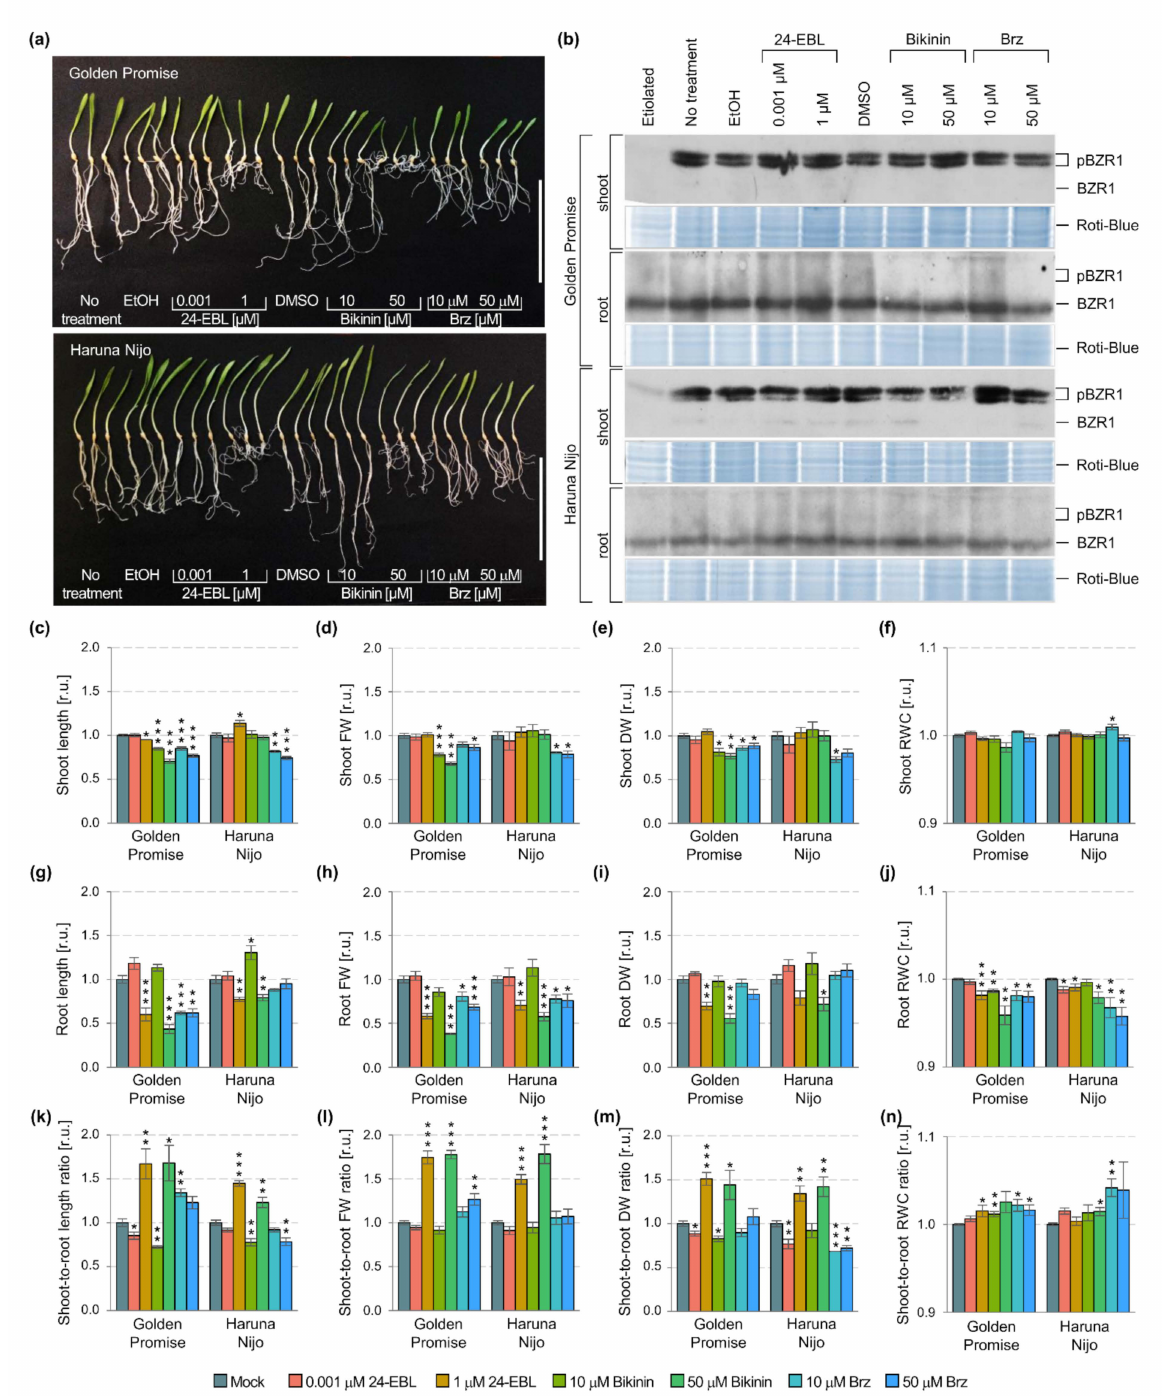
Figure 2. Phenotypic and molecular changes in 5-day-old shoots and roots of the Golden Promise and Haruna Nijo plants treated with 24-EBL (0.001 and 1 µ M), bikinin (10 and 50 µ M), and Brz (10 and 50 µ M). EtOH (0.7%) was used as a control of solvent solutions for 24-EBL, while DMSO (0.7%) was the control of solvent solutions for BK and Brz. Mock represents the plants treated with the respective solvent solutions, i.e., EtOH and DMSO assumed as 1.00. ( a ) A phenotype of plant photography represents three biological replicates for each treatment, scale bar = 10 cm; ( b ) immunodetection of Hv BZR1, the Roti-Blue presents proteins after staining as a loading control; pBZR1 indicates the phosphorylated forms of the Hv BZR1; BZR1 indicates the dephosphorylated form of the Hv BZR1; ( c – f ) growth parameters of shoots, ( g – j ) roots, and ( k – n ) shoot-to-root ratio. The results present the mean with a standard error ( n = 6). The asterisks indicate significant differences, revealed by the Student’s t -test for p < 0.05 (*), p < 0.01 (**), and p < 0.001